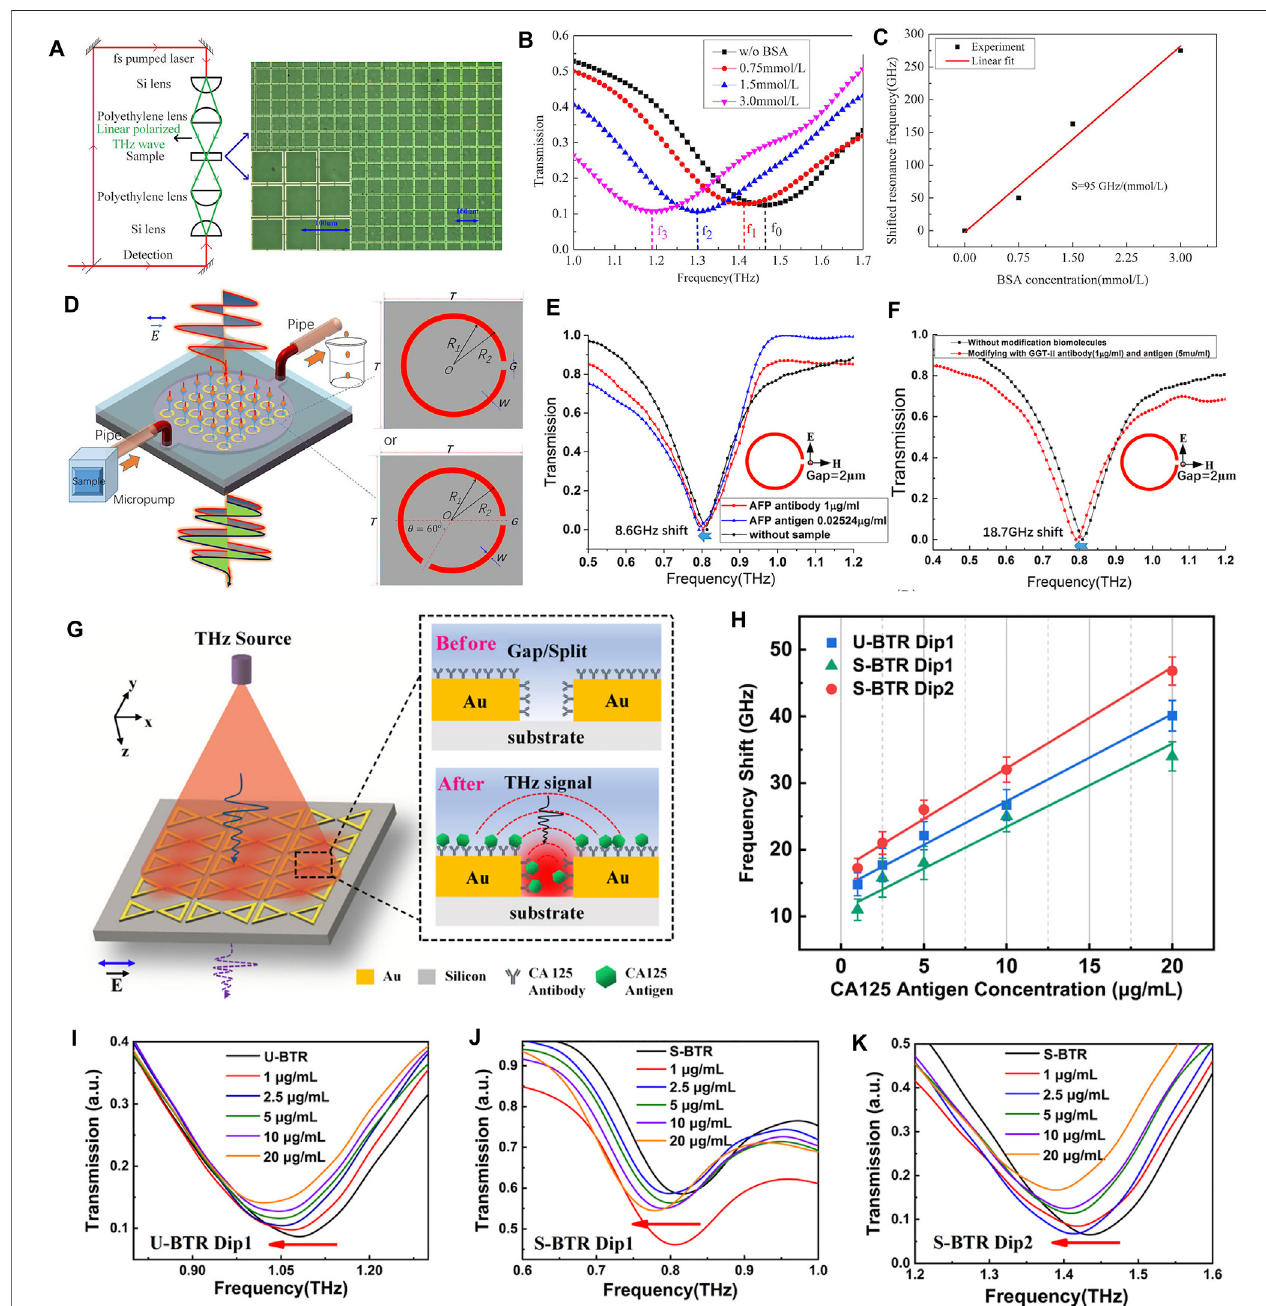
FIGURE 6 | (A) Experimental setup for THz spectral detection combined with metamaterials (B) THz transmission spectra of BSA solutions with different concentrations (C) Least squares fi tting of experimental data of resonant frequencies to BSA concentrations [138]. Reproduced with permission. © 2016 IEEE. (D) THz metamaterialswithintegratedmicro fl uidicsforTHzspectroscopicdetection[140].ReproducedunderaCreativeCommonsAttribution4.0InternationalLicense.©2017 Springer Nature. (E) Transmission spectroscopy ofliver cancer antibody AFP (1 μ g/ml) and liver cancer serum antigen (0.02524 μ g/ml) were detected using SRRs biosensorswithagapof2 µm.ThefrequencyshiftofthetransmissionspectrumbeforeandafterinjectionofAFPantibodyandserumantigenwas8.6 GHz[140] (F) The liver cancer biomarkers GGT-II antibody (1 μ g/ml) and GGT-II antigen (5 μ g/ml) were also detected by the same method. The transmission spectra were shifted by 18.7 GHz before and after injection of GGT-II antibody and antigen [140] (G) THz metamaterials for biomedical detection and the mechanism of reaction of their electric fi elds with analytes (H) Frequency shifts based on three dips for different concentrations of CA125 antigen and fi xed concentrations (30 μ g/ml) of CA125 antibody; transmission spectra of (I) U-bowtie triangle ring (BTR) Dip1 (J) S-BTR Dip1 and (K) S-BTR Dip2 at different concentrations of CA125 antigen [145]. Reproduced with permission. © 2021 American Chemical Society.